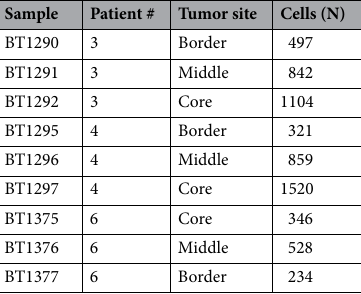
Table 1. Samples used for data analysis (E-MTAB-6149 and E-MTAB-6653).